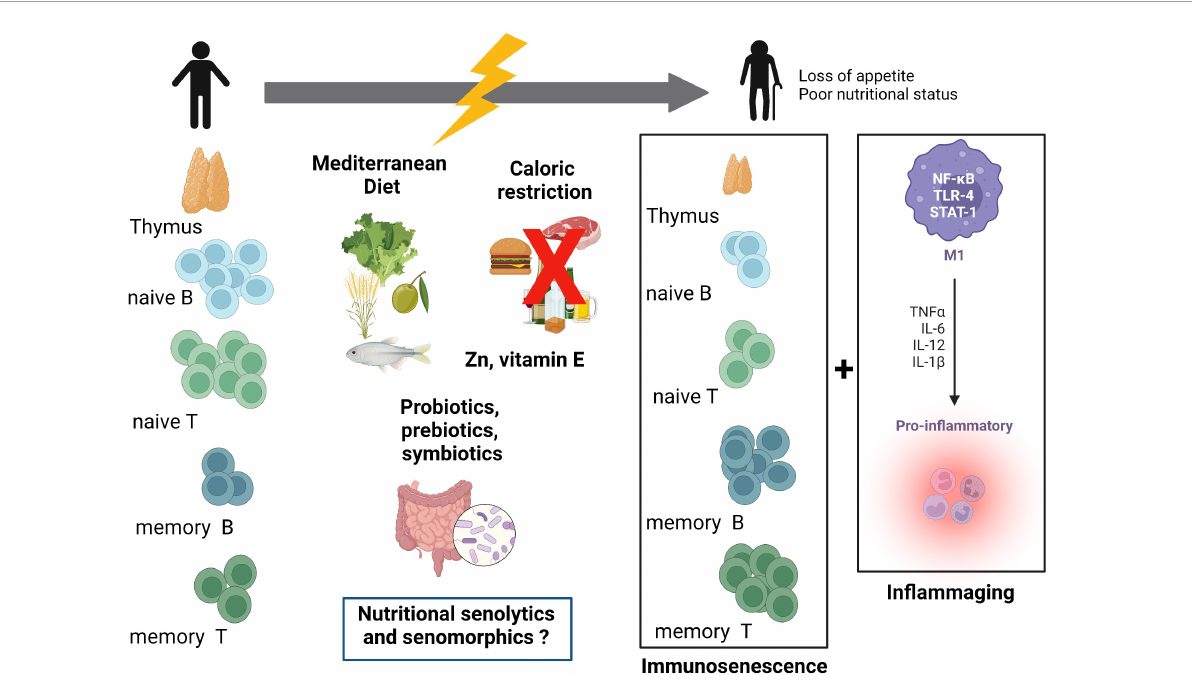
FIGURE2 Relation between immunosenescence, inflammaging, and nutrition. Immune cells and the thymus are affected during the aging process. Thymic atrophy, reduction of naïve B- and T-cells, and increase in memory B- and T-cells are hallmarks of immunosenescence. These events together with increased low-grade inflammation (inflammaging) may constitute potential targets for nutritional interventions. Mediterranean diet, caloric restriction, vitamin E, zinc, and probiotics are possible modulators of immunosenescence and inflammaging. Nutritional senotherapeutics may be an additional form of targeting aging, as part of a personalized nutrition approach. TLR-4, toll-like receptor-4; STAT-1, signal transducer and activator of transcription 1; M1, macrophage M1 subpopulation. Created with